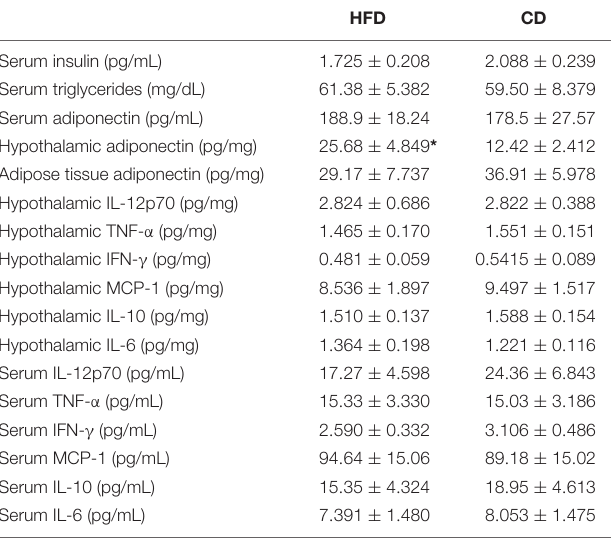
TABLE 1 | Wild-type C57BL/6 mice after 11 weeks on HFD or